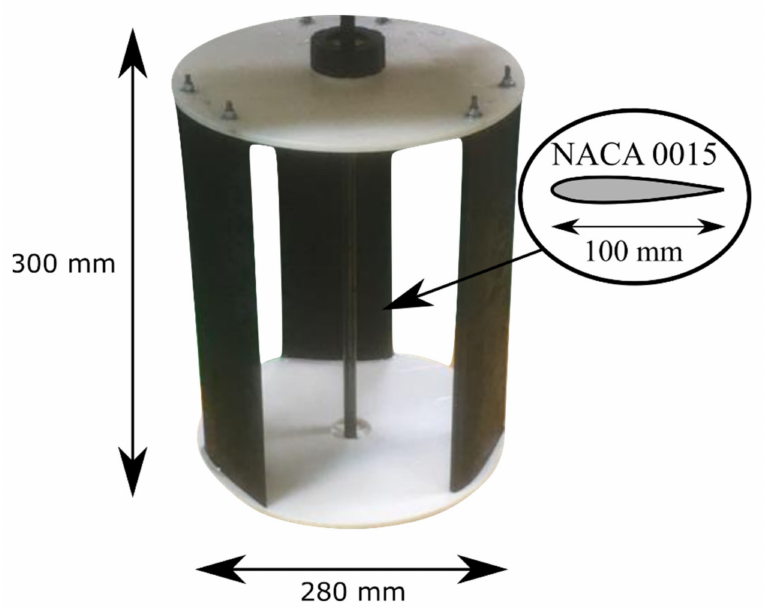
Figure 1. Darrieus rotor design tested, with the geometrical